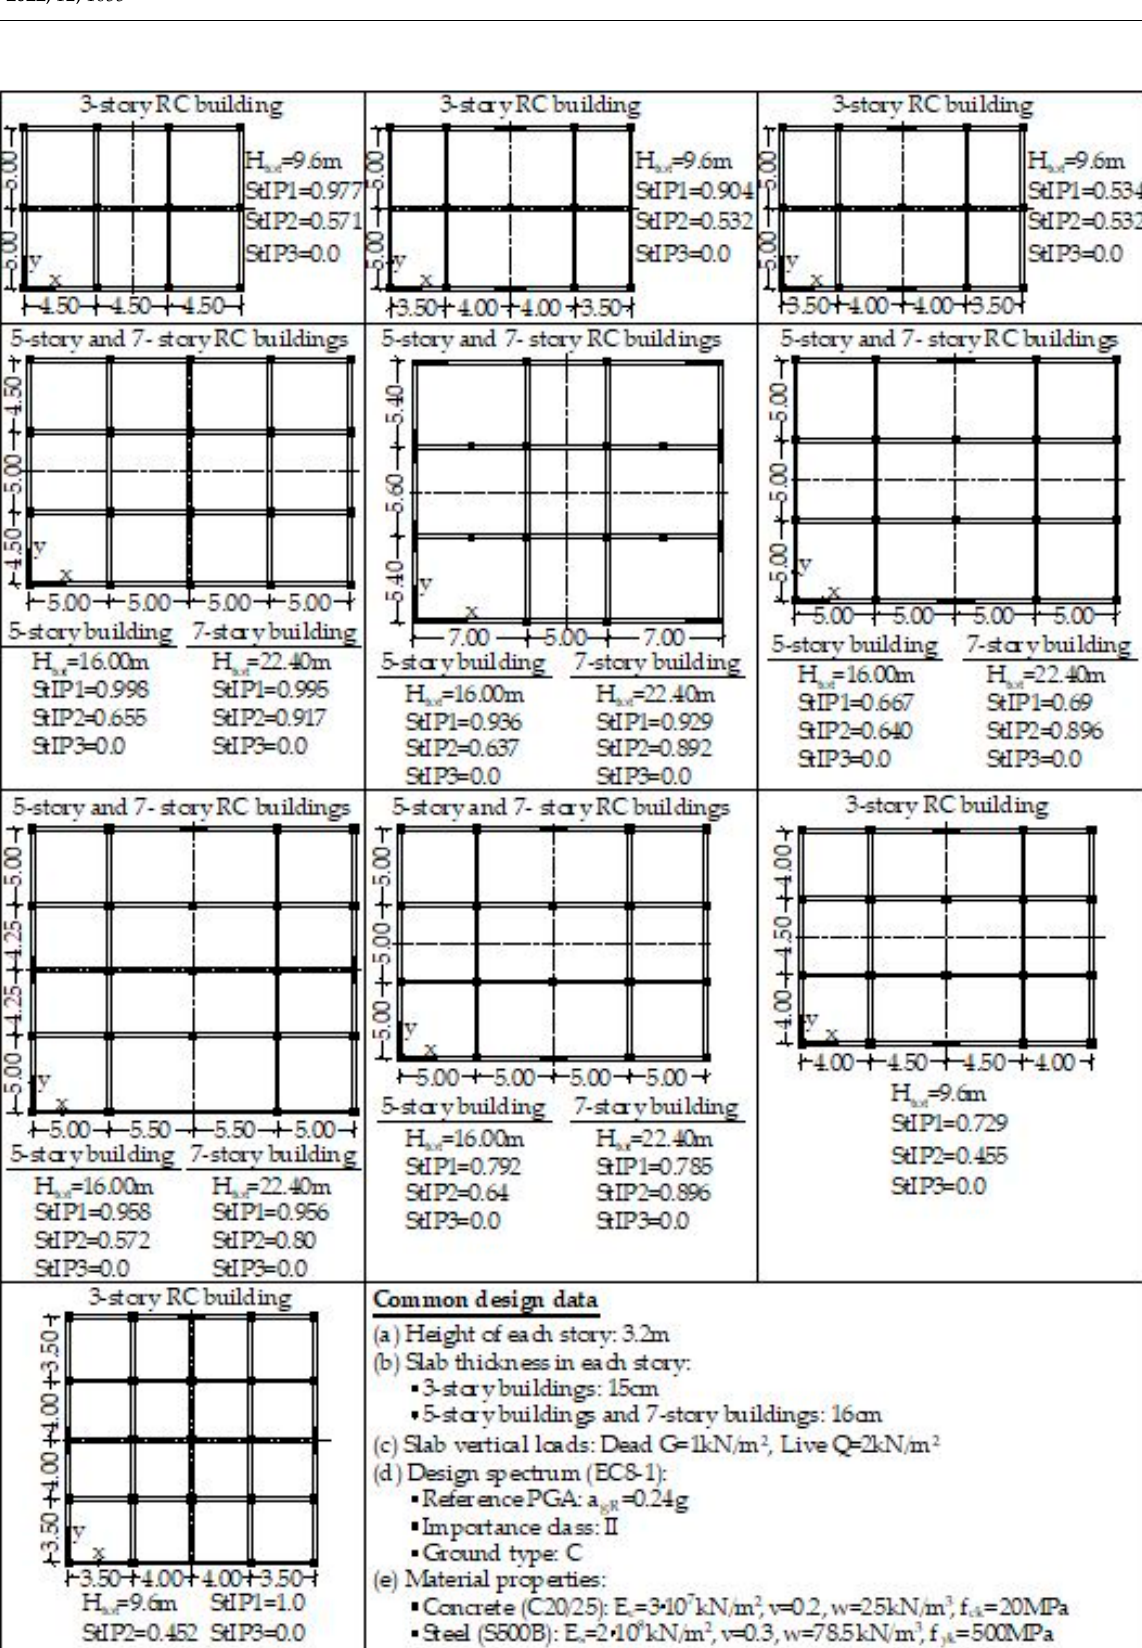
Figure A1. Design data of the 15 selected symmetric RC buildings.